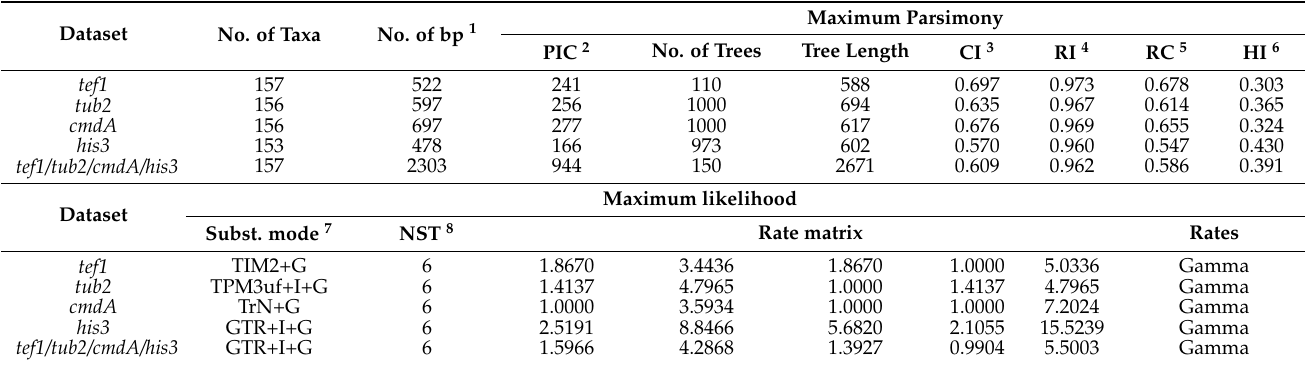
Table 5. Statistical values of datasets for maximum parsimony and maximum likelihood analyses in this study.